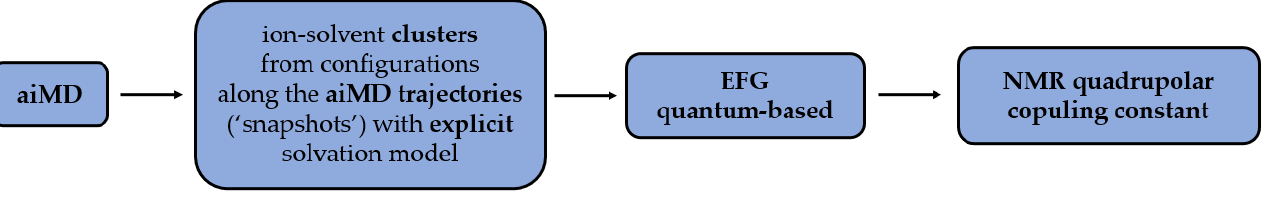
Figure 2. One of approaches used to calculate EFG.